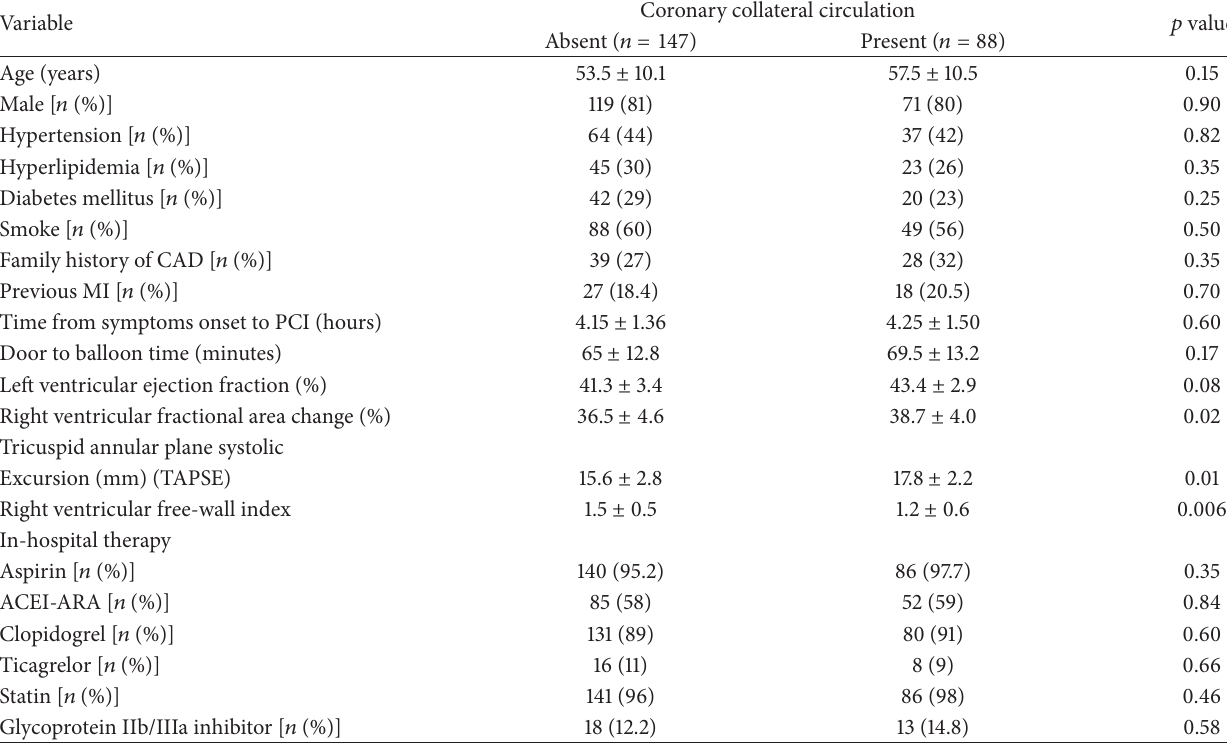
Table 1: Baseline clinical, echocardiographic characteristics and in-hospital